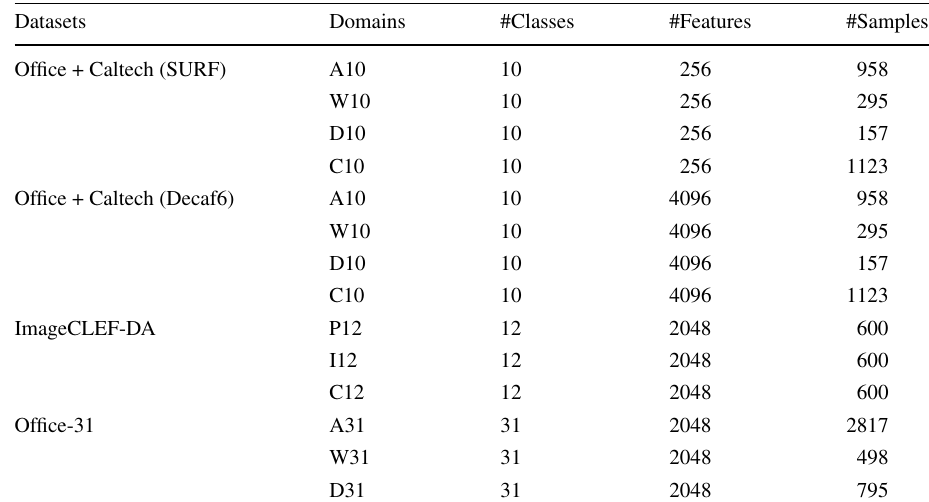
Fig. 3 Exemplary images from different datasets Table 1 Datasets